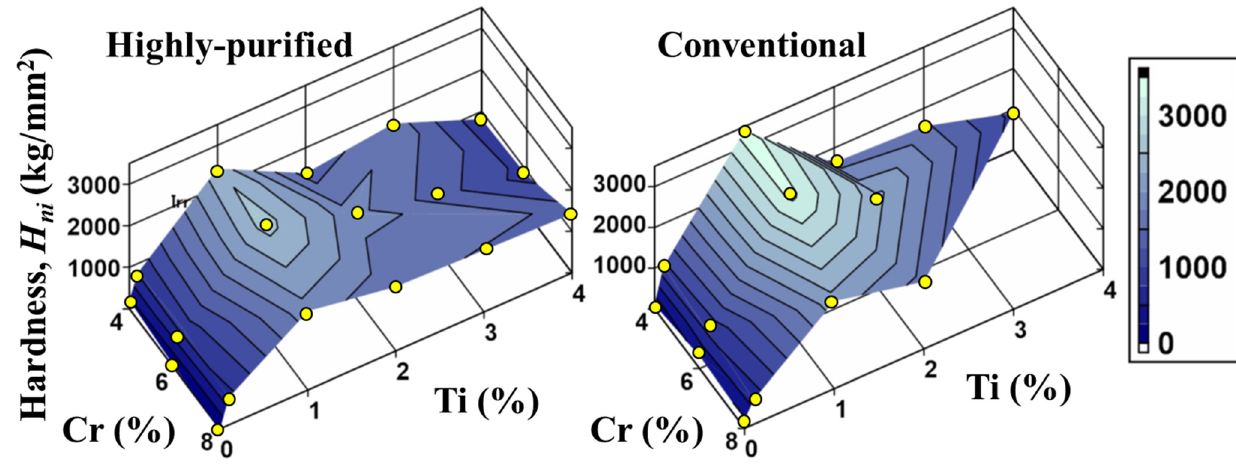
Figure 7. Profiles of hardness increases for He-irradiated V–Cr–Ti alloys at 500 °C. The left profile indicates V–Cr–Ti(h) alloys with a highly purified impurity level and the right profile indicates V–Cr–Ti alloys with a conventional impurity level.